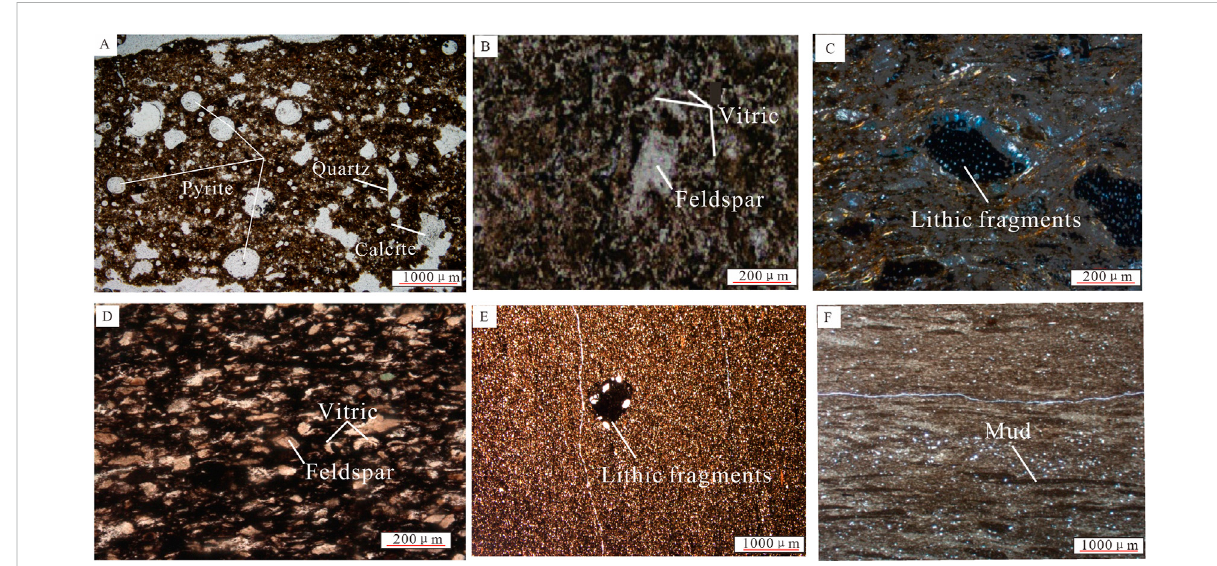
FIGURE 3 Thin section characteristics for typical lithology of longtan formation/wujiaping formation. (A) :Well FS1,Wu No. 2section, 4,832 m, tuff inlithic fragments, with quartz crystal fragments and pyrite, volcanic ash cementation; (B) : Well Y7, Wu No. 2 section, 6,915 m, tuff in crystal fragments, with feldspar crystal fragments, vitric fragment de-vitri fi cation, volcanic ash cementation; (C) : Well TF2, Longtan Formation, 5,158.16m, sedimentary tuff, with large lithic fragment and in an obvious tuffaceous structure; (D) : Well NC2, Longtan Formation, 5,869 m, sedimentary tuff, with feldspar crystal fragments and vitric fragments; (E) : Well ST1, Wu No.2 section, 6,725 m, tuffaceous mudstone, with large lithic fragments; (F) : bottom of Longtan Formation for Huaying Mountain pro fi le, tuffaceous mudstone, in stripes.